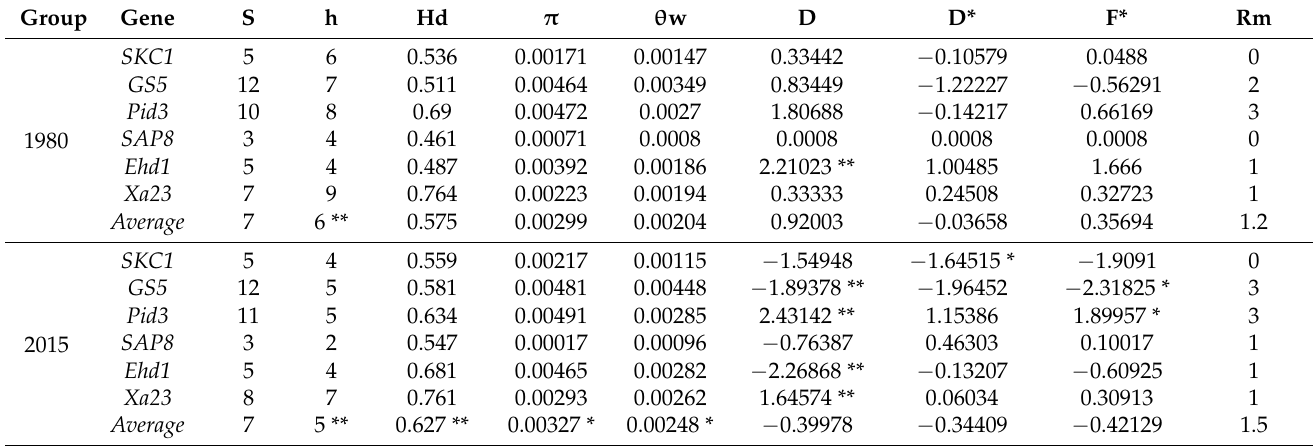
Table 4. Summary of nucleotide polymorphisms and neutrality test.